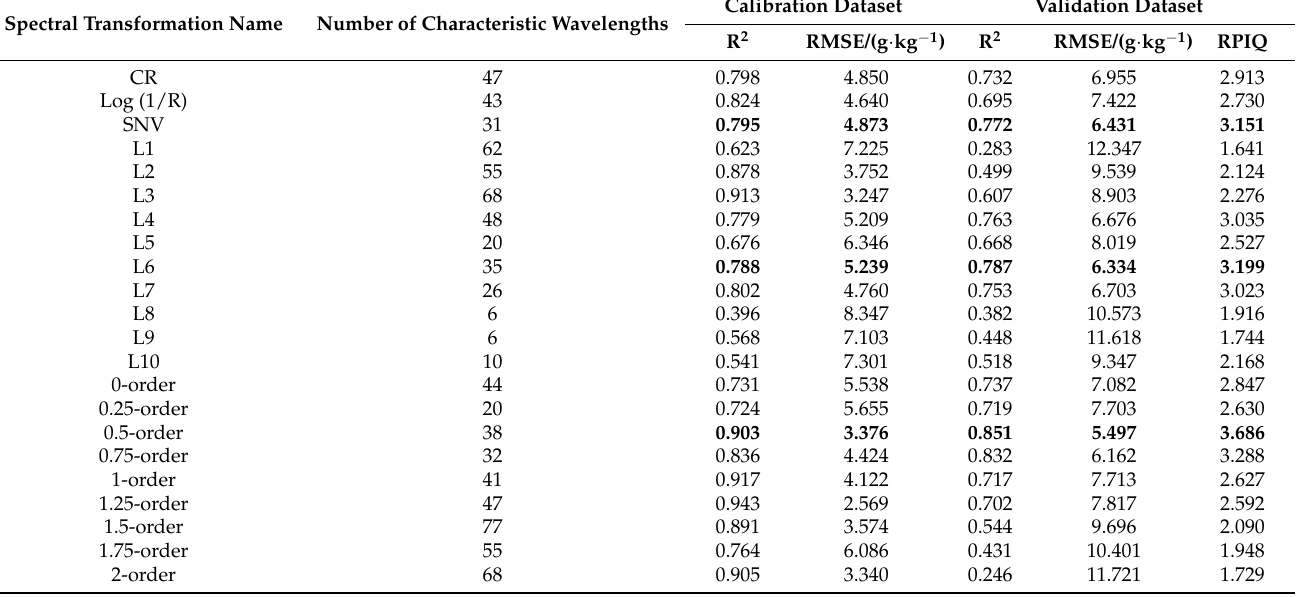
Table 7. The results of the BPNN estimation of soil iron oxide content using characteristic